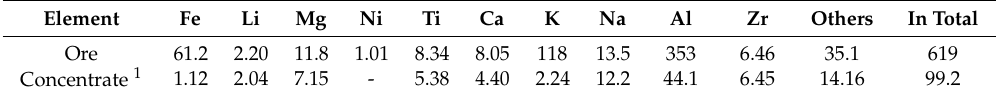
Table 1. Contents of main impurity elements in quartz sand ( µ g/g)